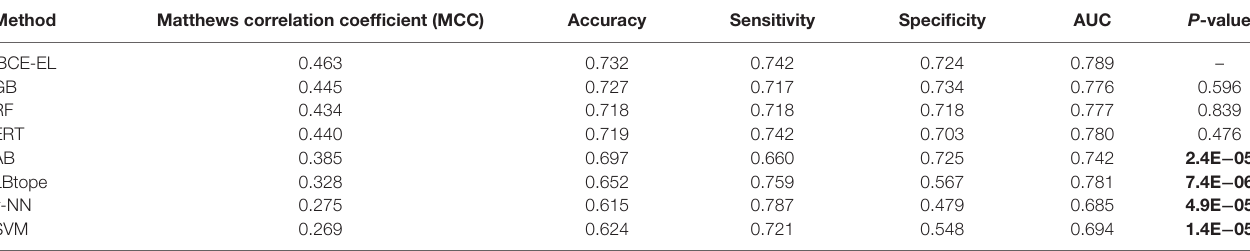
tABLe 2 | Performance comparison of the iBCE-EL with other methods on independent data